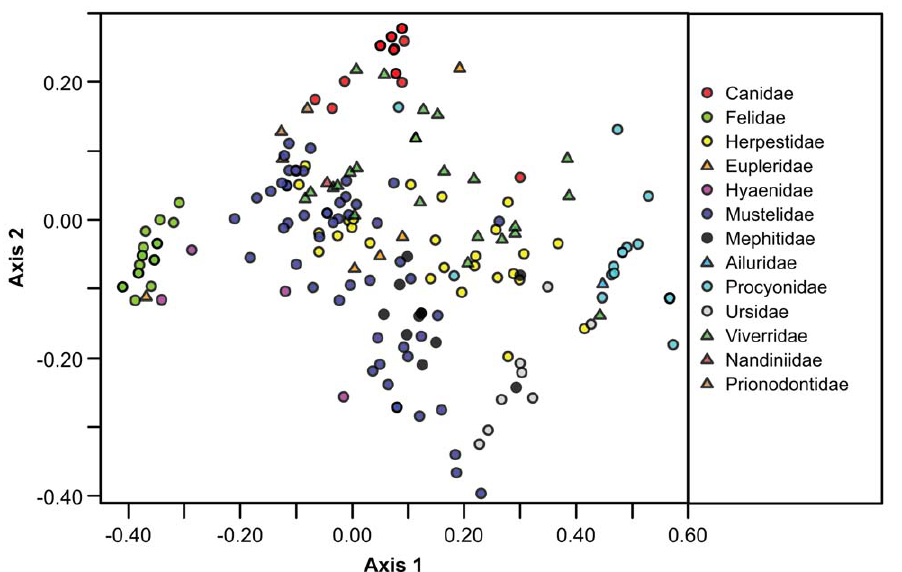
Figure 1. Diagram of the first two axes of the correspondence analysis. The position of each of the families of Carnivora in the morphospace of 216 extant species in our dataset is shown. On Axis 1, note the continuum from hypercarnivores (negative end) to hypocarnivores (positive end). Axis 2 reflects premolar variation, with species with a complete and long premolar row at the positive end and species with reduced or absent premolars at the negative end.